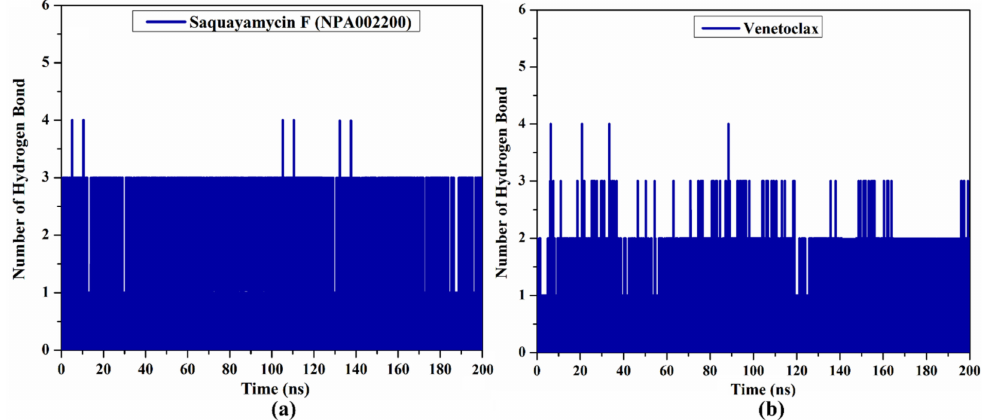
Figure 7. The number of hydrogen bonds over 200 ns MD simulations for ( a ) saquayamycin F (NPA002200) and ( b ) venetoclax complexed with the Bcl-2